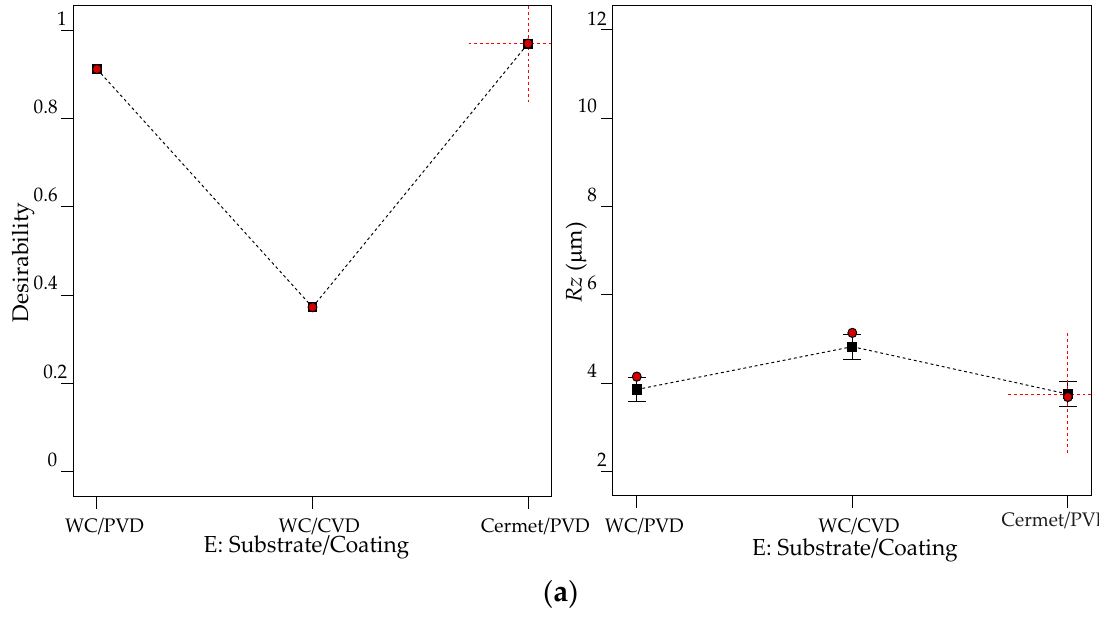
Figure 13. Graphs of optimization results to minimize Ra as goal: ( a ) effect of cutting tool type; ( b ) interaction effects of Substrate/Coating* r and Substrate/Coating*f; ( c ) Ra contour levels of interactions DOC* r and r * f .